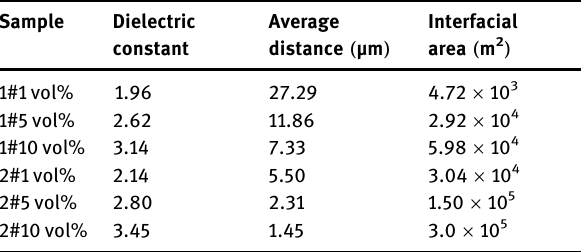
Table 1: The average distance and interfacial area of the CCTO/LDPE and CCTZO/LDPE composites with di ff erent loading content for CCTO or CCTZO particle fi llers at 10 Hz Sample